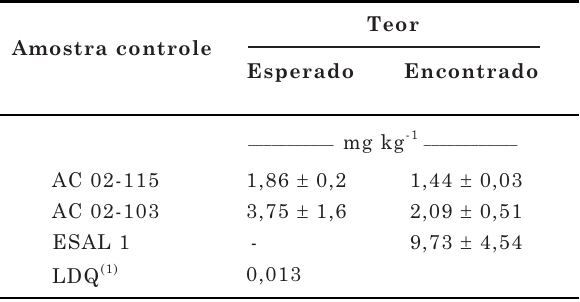
das amostras; M: média das provas em branco; k: coeficiente de Kaiser que possui valor fixo igual a 3 (Skoog, 2002); e s: desvio-padrão das provas em